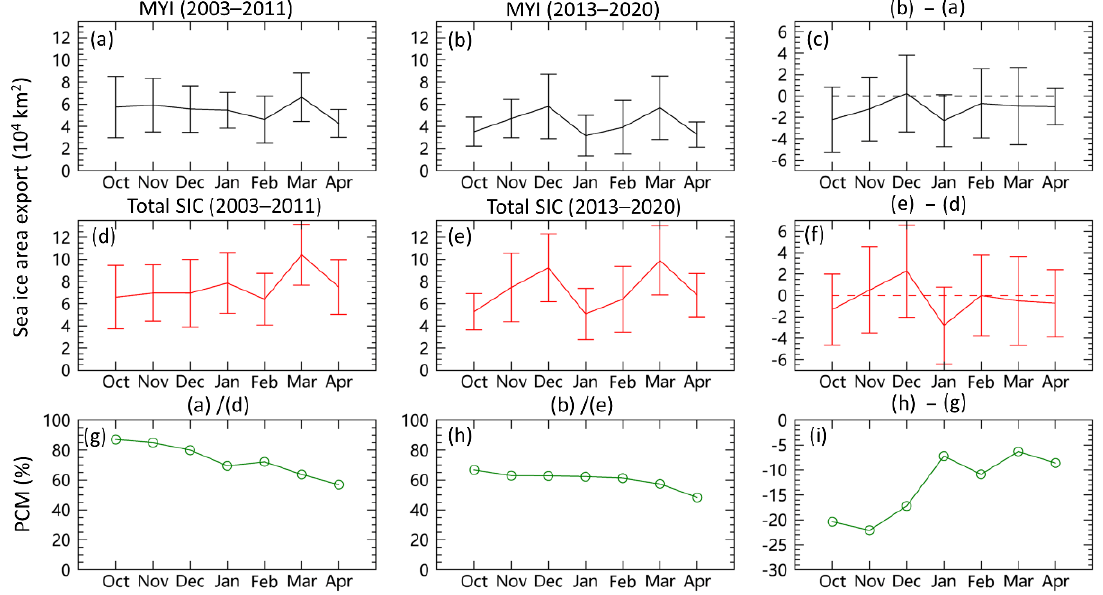
Figure 3. The seasonal cycle of MYI ( a , b ) and total sea ice ( d , e ) area export through the FS in D1 and D2. PCMs in D1 and D2 are reflected in ( g ) and ( h ) respectively. Differences between ice exports in two periods are displayed in the last column of panels ( c , f,i ). Table 2. Monthly MYI area export through the FS (10 4 km 2 ).